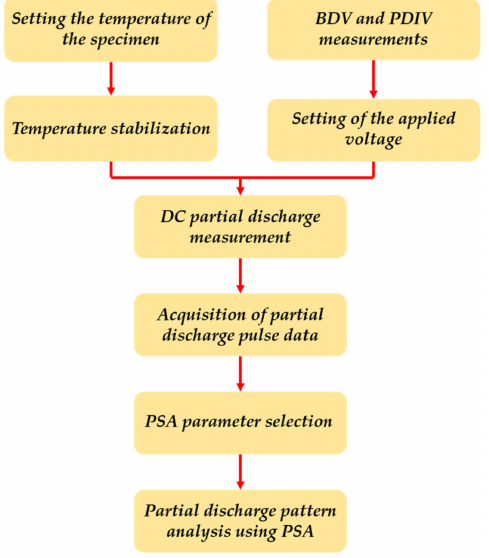
Figure 4. Process of acquiring the DC partial discharge